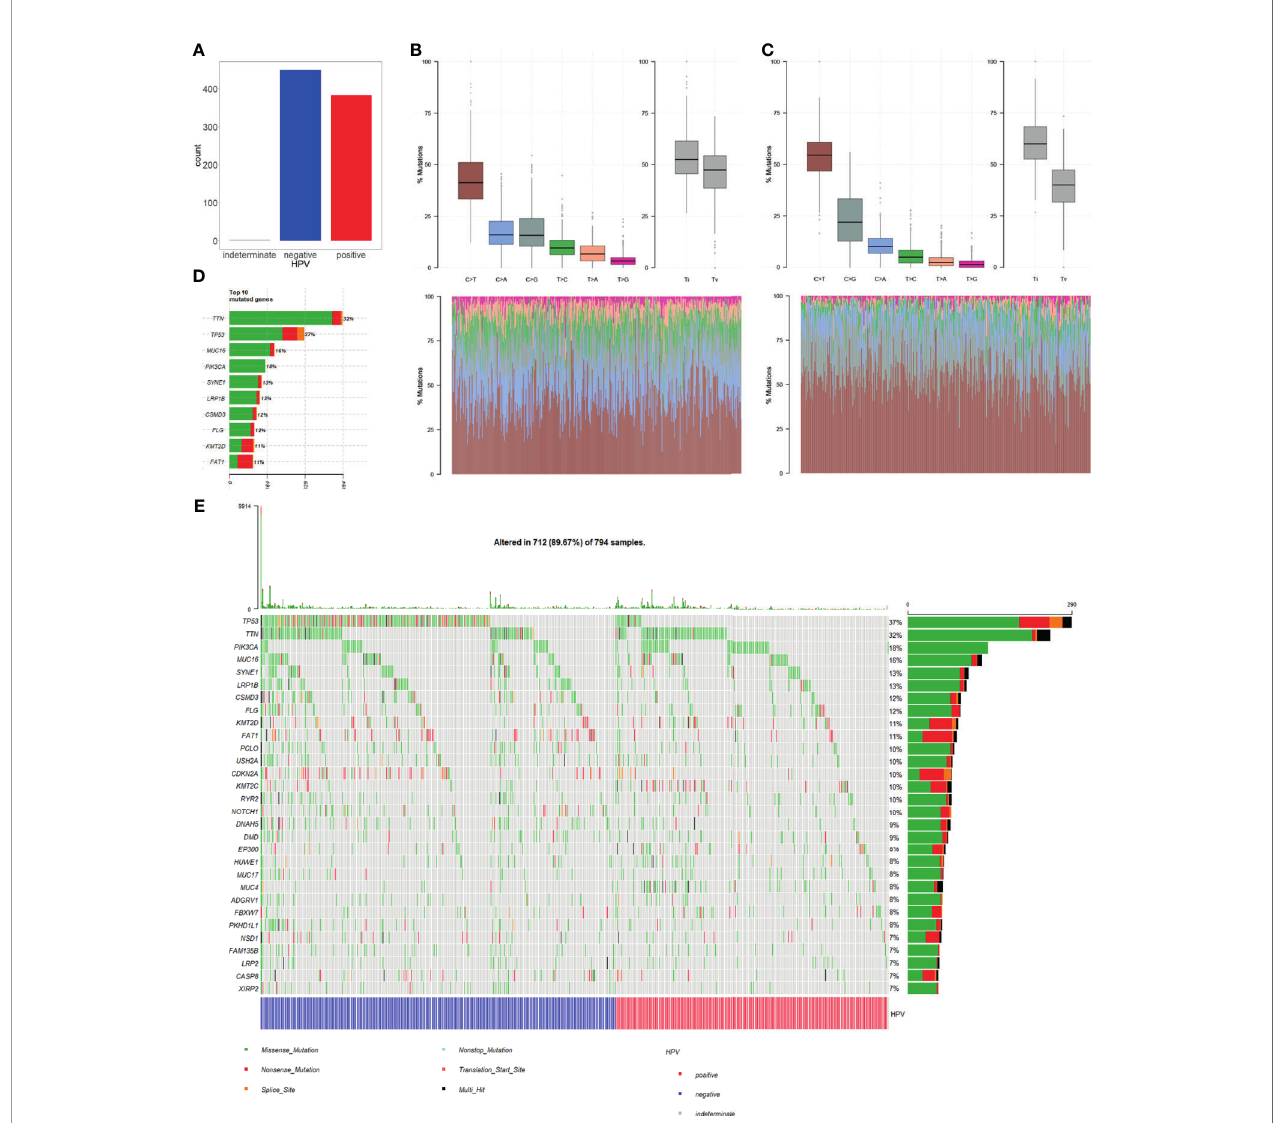
FIGURE 2 | Single nucleotide variation (SNV) in HPV+ cancers and HPV − cancers. (A) Total numbers of HPV+ samples and HPV − samples in SNV data of TCGA CESC and HNSC project. MUSE software processed SNV data was used in our study. (B) HPV+ samples single nucleotide mutation-type proportions. (C) HPV − samples single nucleotide mutation-type proportions. (D) Top 10 highly mutation rates and mutated sample counts of mutated genes. (E) Oncoplot of the top 30 highly mutated genes; samples were grouped by HPV infection